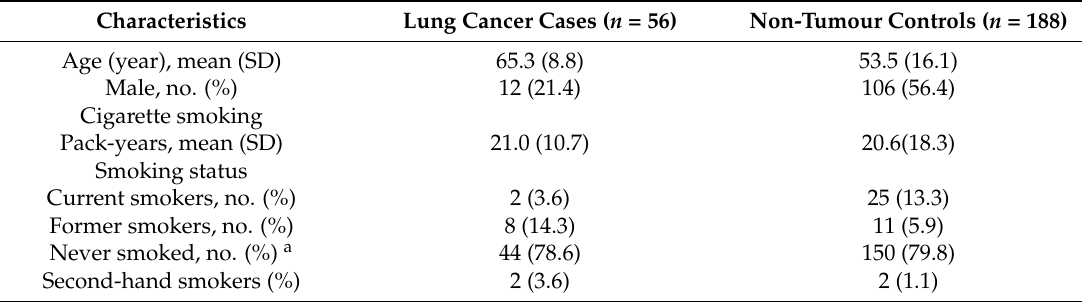
Figure 2. Flow diagram depicting the inclusion and exclusion of the study subjects. We employed an independent external validation set and conducted a repeated double cross-validation. The repeated double cross-validation used two nested loops. The inner loop used the study subjects enrolled between 2016 and 2017 as a calibration set for model selection and parameter optimization and were divided into a training set (80%) and an internal validation set (20%). The outer loop used the prediction model established from the calibration set to externally validate the study subjects enrolled in 2018. Table 1. Demographic characteristics of the study subjects.